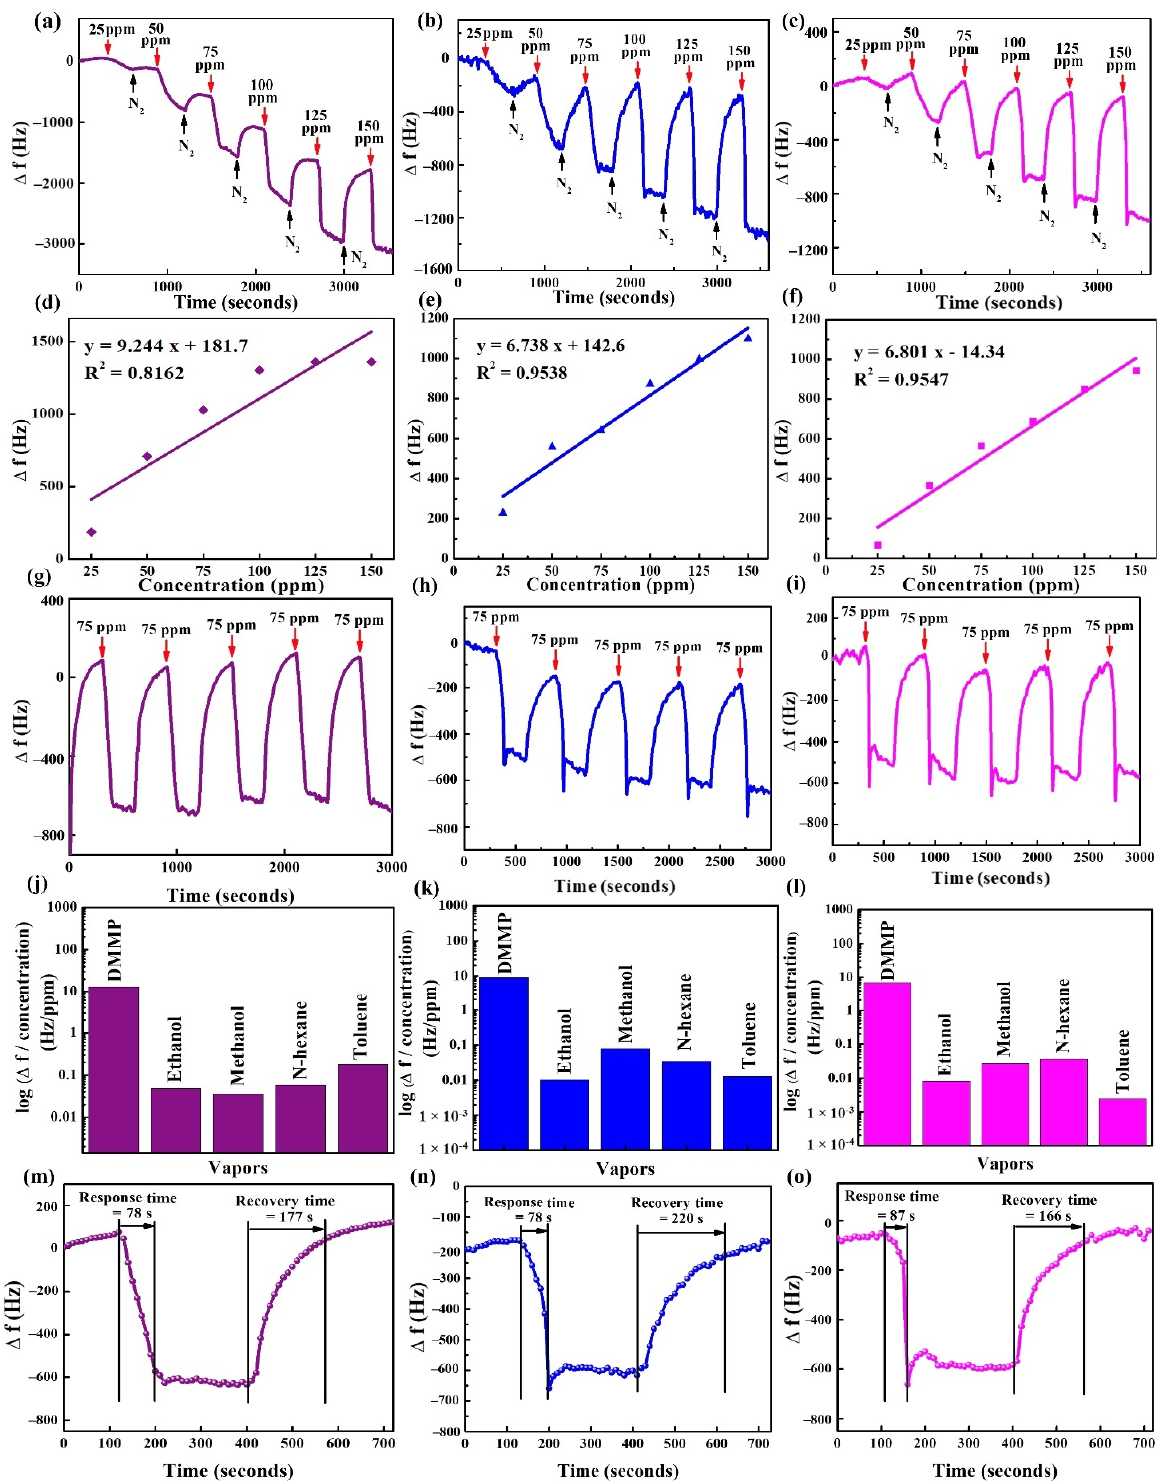
Figure 12. Frequency shifts of ( a ) CE, ( b ) MnO 2 @CE, ( c ) MnO 2 @CE/PPy; linearity of ( d ) CE, ( e ) MnO 2 @CE, ( f ) MnO 2 @CE/PPy; Repeatability of ( g ) CE, ( h ) MnO 2 @CE, ( i ) MnO 2 @CE/PPy, for 75 ppm DMMP; selectivity of ( j ) CE, ( k ) MnO 2 @CE, ( l ) MnO 2 @CE/PPy; and response/recovery times of ( m ) CE, ( n ) MnO 2 @CE, ( o ) MnO 2 @CE/PPy, for 75 ppm DMMP; in the SAW sensor. CE-, MnO 2 @CE-, and MnO 2 @CE/PPy-coated SAW sensors were exposed to the DMMP and several VOCs, such as n-hexane, methanol, toluene, and ethanol, at the